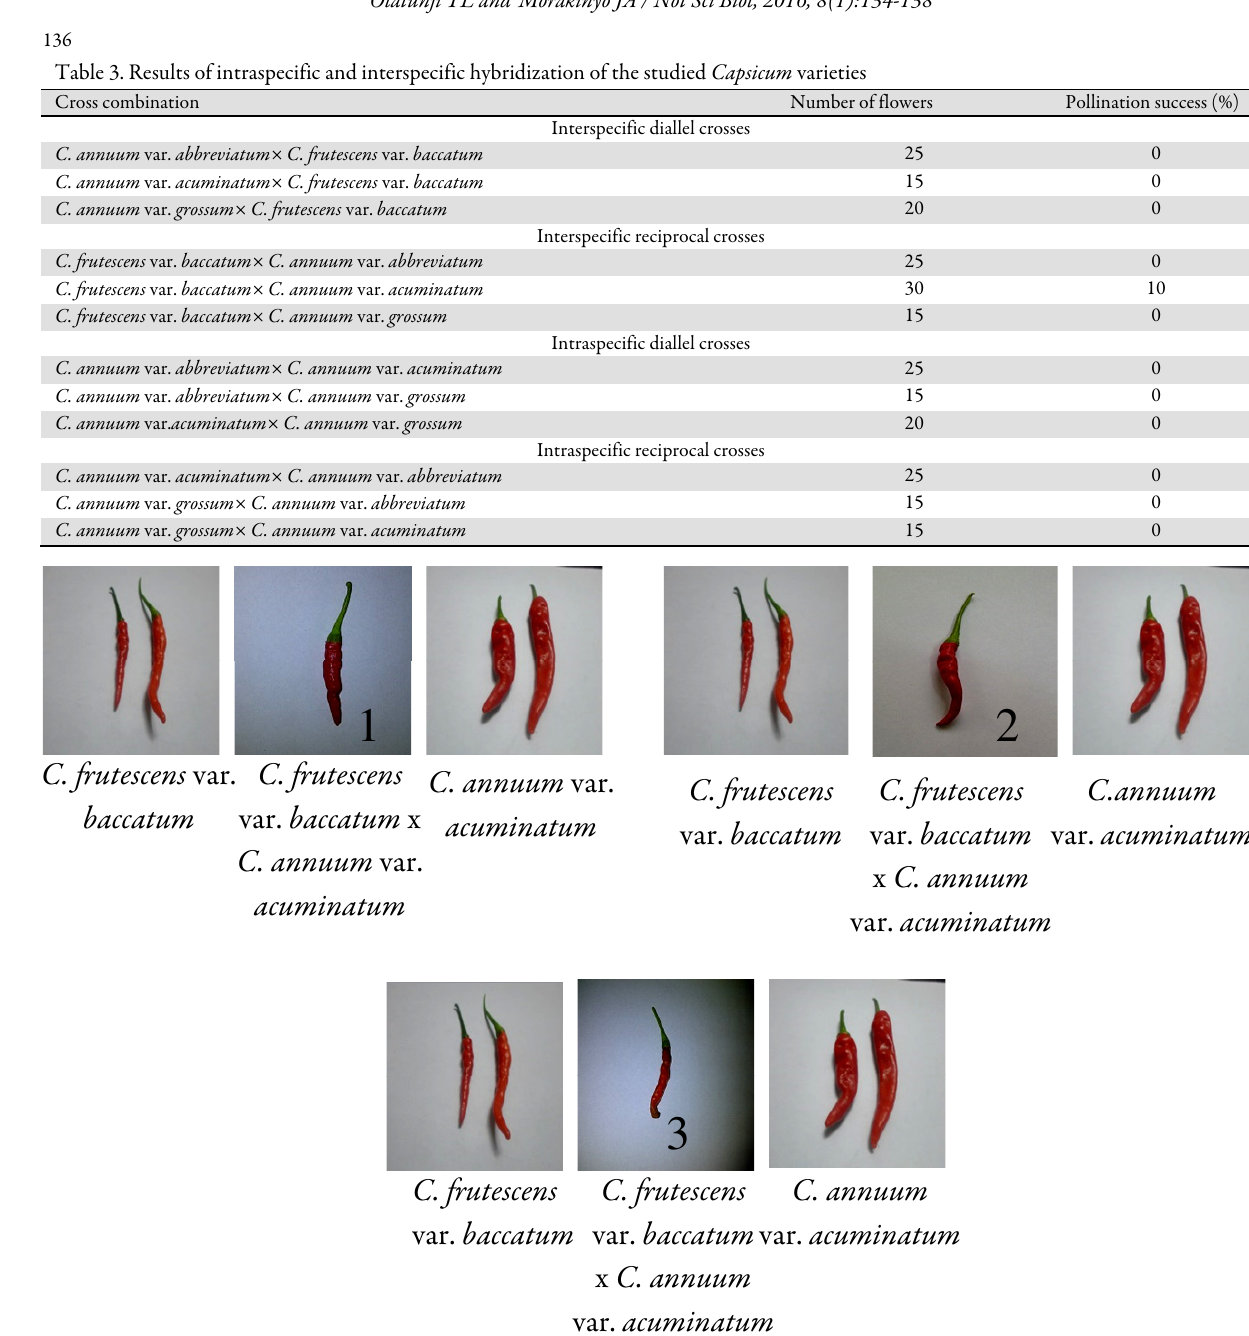
Fig. 2. The fruits of parental genotypes and the hybrids. Parents: C. frutescens var. baccatum and C. annuum var.